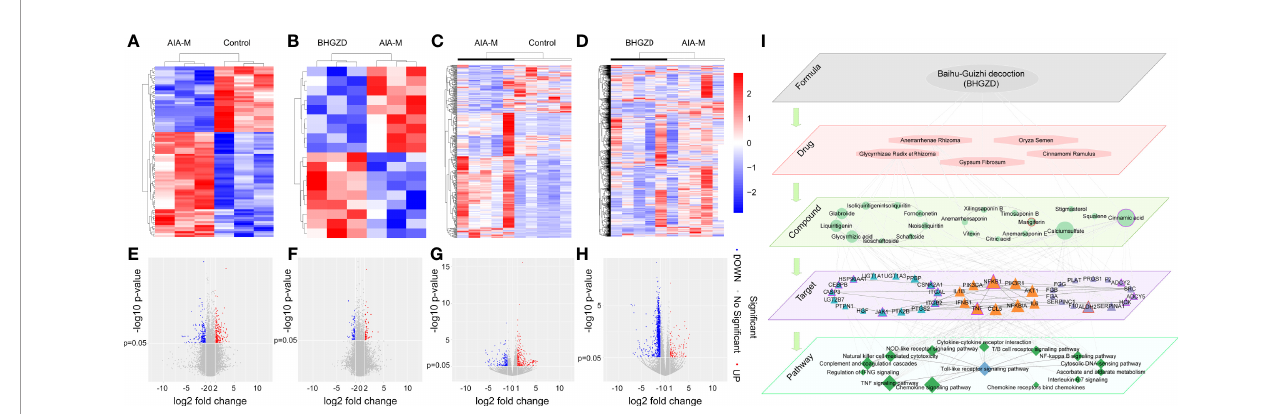
FIGURE 1 | Transcriptomic pro fi ling-based differential data analysis and biomolecular network-based investigation of AIA-M candidate markers and candidate targets of Baihu-Guizhi decoction (BHGZD) against AIA-M (Control, AIA-M, BHGZD). (A) The heatmap of the signi fi cant differentially expressed genes (DEGs) between the AIA-M model group and the normal control group in synovium using microarray analysis ( n = 3 per group). (B) The heatmap of DEGs between the BHGZD treatment group and the AIA-M model group in synovium using microarray analysis ( n = 3 per group). (C) The heatmap of the DEGs between the AIA-M model group and the normal control group in whole blood cells using RNA sequencing (RNA-Seq) analysis ( n = 5 per group). (D) The heatmap of DEGs between the BHGZD treatment group and the AIA-M model group in whole blood cells using RNA-Seq analysis ( n = 5 per group). (E) The volcano plot of the DEGs between the AIA-M model group and the normal control group in synovium using microarray analysis ( n = 3 per group). (F) The volcano plot of the DEGs between the BHGZD treatment group and the AIA-M model group in synovium using microarray analysis ( n = 3 per group). (G) The volcano plot of the DEGs between the AIA-M model group and the normal control group in whole blood cells using RNA sequencing (RNA-Seq) analysis ( n = 5 per group). (H) The volcano plot of the DEGs between the BHGZD treatment group and the AIA-M model group in whole blood cells using RNA-Seq analysis ( n = 5 per group). (I) The subnetwork of the “ formula-drug- compound-target-pathway ” network is constructed using the links between key RA-related genes and BHGZD effective genes. The ellipse refers to BHGZD. Light orange hexagons refer to drugs contained in BHGZD. Green circles refer to compounds contained in BHGZD. Triangles refer to targets. Green diamonds refer to pathways. Triangles with red circles refer to the targets of mangiferin (MG). Triangles with purple circles refer to the targets cinnamic acid